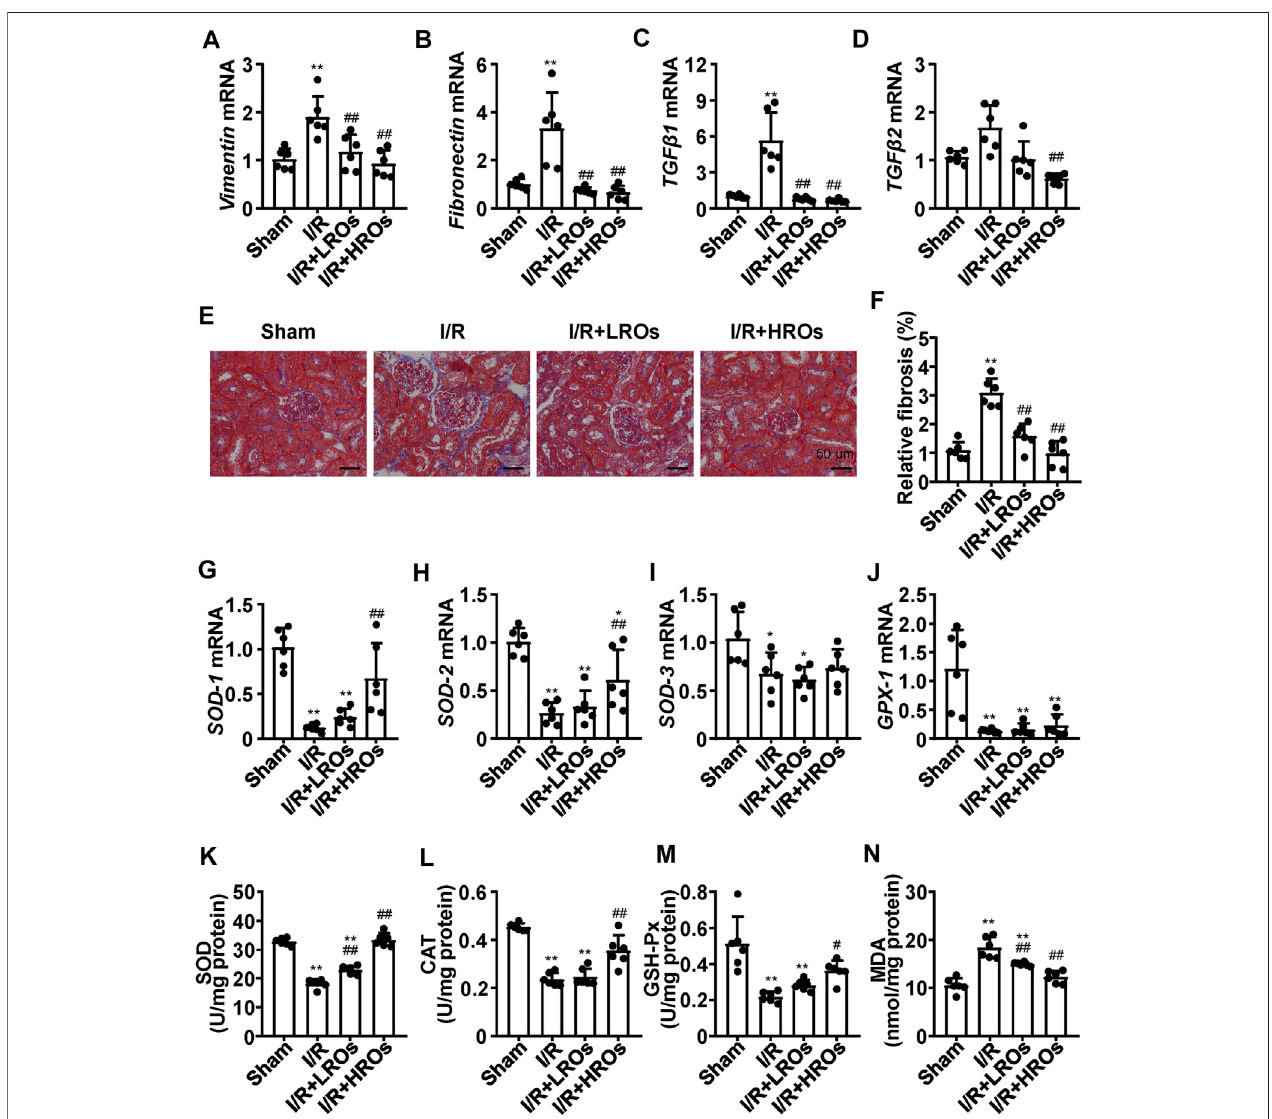
FIGURE 2 | Suppression of I/R-induced fi brosis and oxidative stress with riclinoctaose. (A – D) mRNA levels of fi brotic genes, Vimentin (A), Fibronectin (B), TGF- β 1 (C), and TGF- β 2 (D) in kidneys of the sham group, I/R group, I/R + LROs group, and I/R + HROs group. (E) Representative Masson ’ s Trichrome stain of kidneys in each micegroup. (F) QuantitativeresultsofMassonstaining. (G – J) mRNAlevelsofcellular antioxidant enzymes, SOD-1 (G), SOD-2 (H), SOD-3 (I),and GPX-1 (J)inkidneysof each mice group. (K – M) Antioxidantenzymes SOD(K),CAT (L),and GSH-Px(M)activitiesinthekidneysofeachmice group. (N) Lipidperoxidation productsMDA levelinkidneysofeachmicegroup.ROs:Riclinoctaose.Dataareexpressedasmean ± SD.n (cid:1) 6,* p < 0.05,** p < 0.01comparedwiththeshamgroup;# p < 0.05,## p < 0.01 compared with the I/R group. Data were analyzed by the two-way ANOVA followed by Bonferroni post hoc analysis.